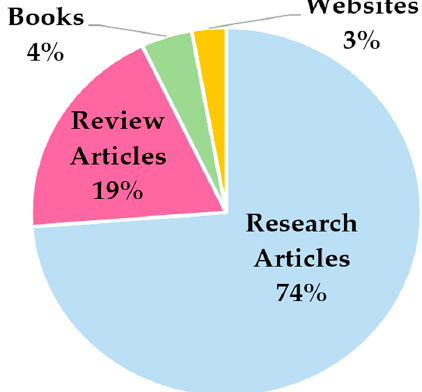
Figure 1. Workflow describing the selection process involved in the presented review paper.